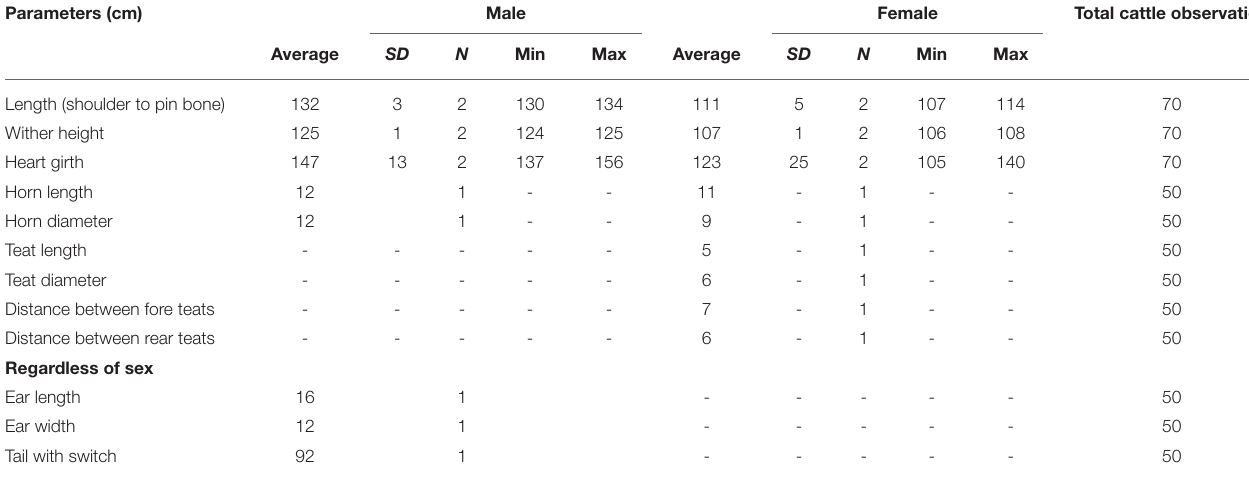
TABLE 4 | Physical measurements of mature Red Chittagong cattle. Parameters